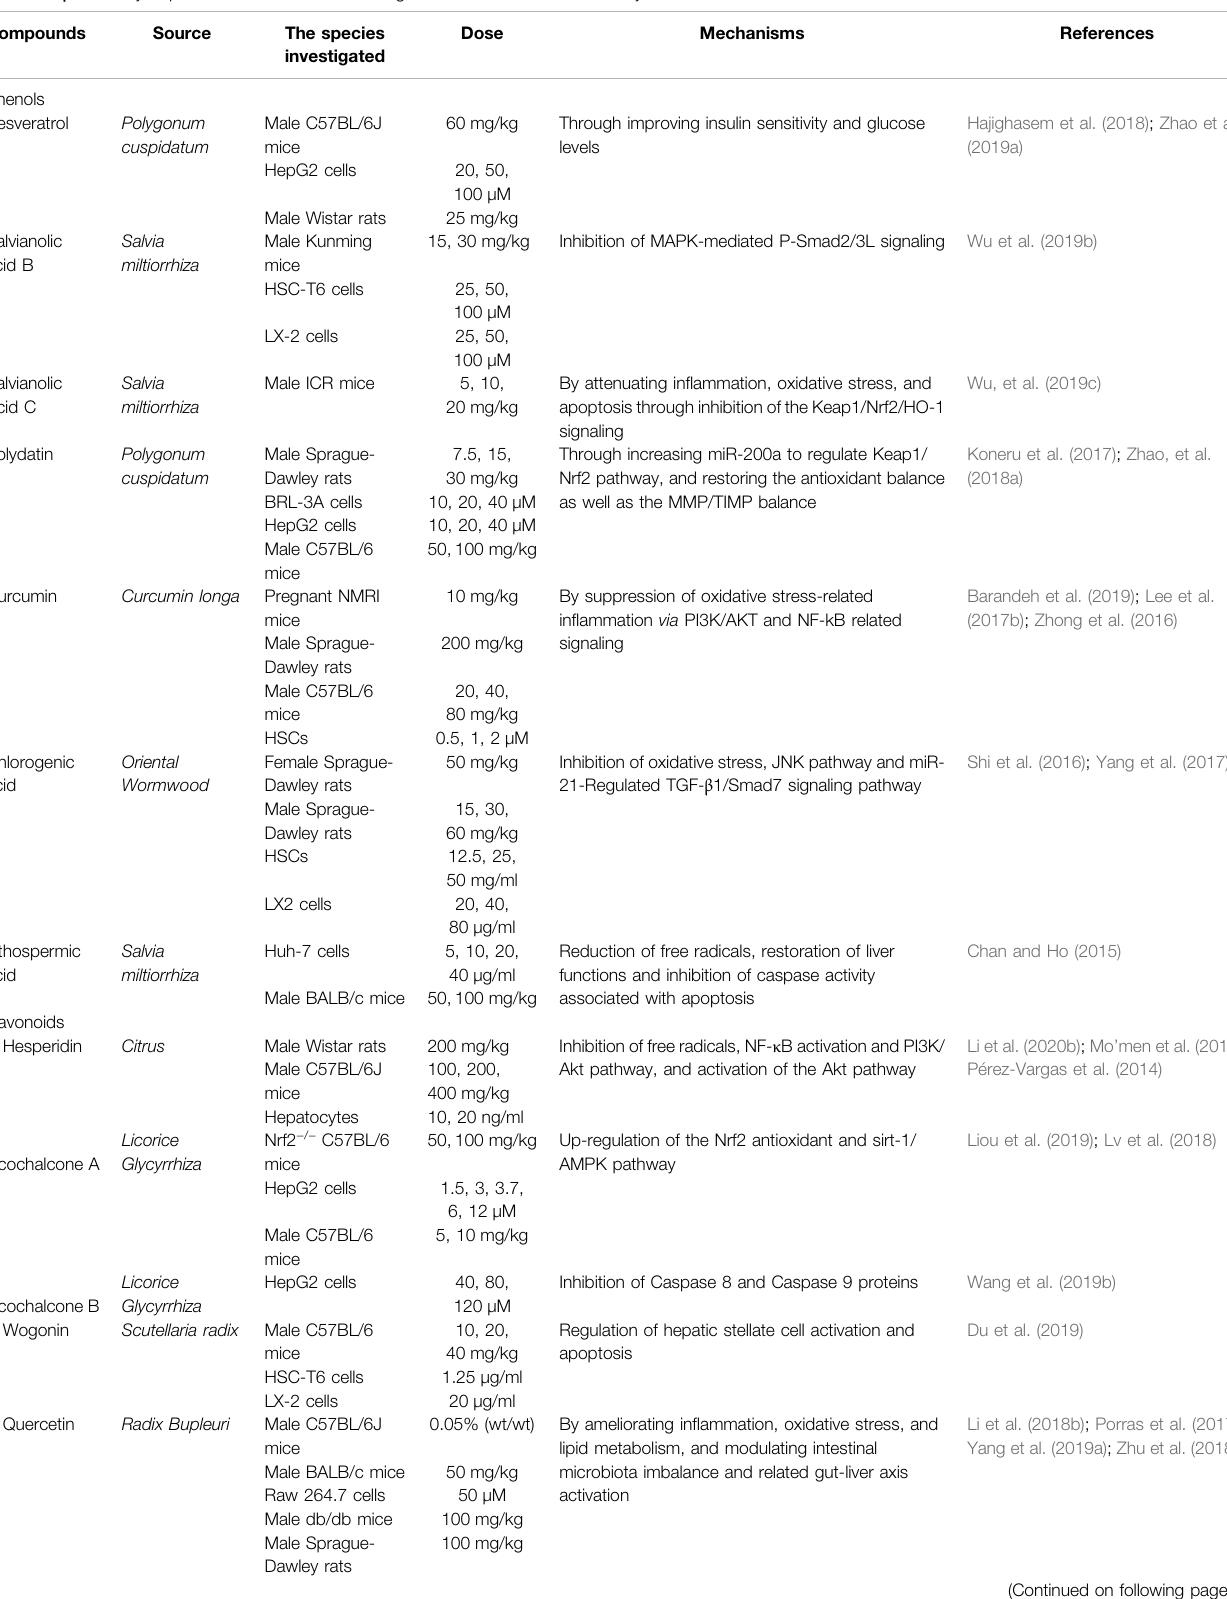
TABLE 3 | Summary of phenols and fl avonoids with signi fi cant anti-liver disease activity.